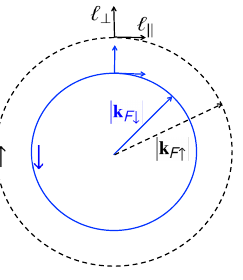
FIG. 8. Mismatched Fermi surfaces and local coordinate systems in momentum space.